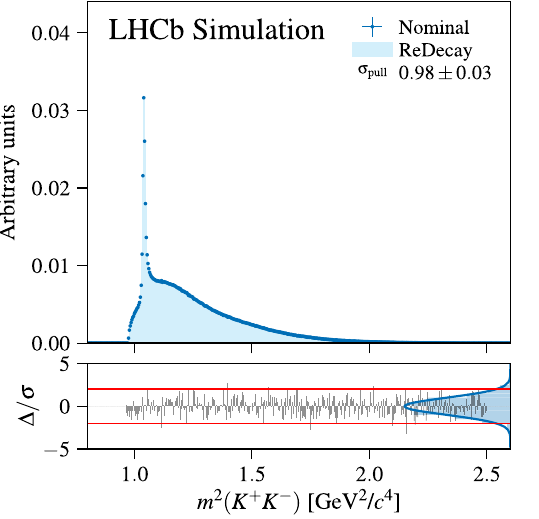
pendent of the kinematics of the decaying particle. Displayed uncer- tainties are computed assuming independent events. There is no sign of the effects caused by correlated events as seen in Fig. 1